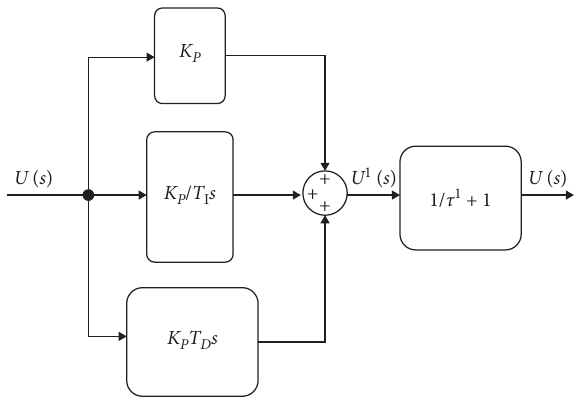
Figure 3: Differential passivation